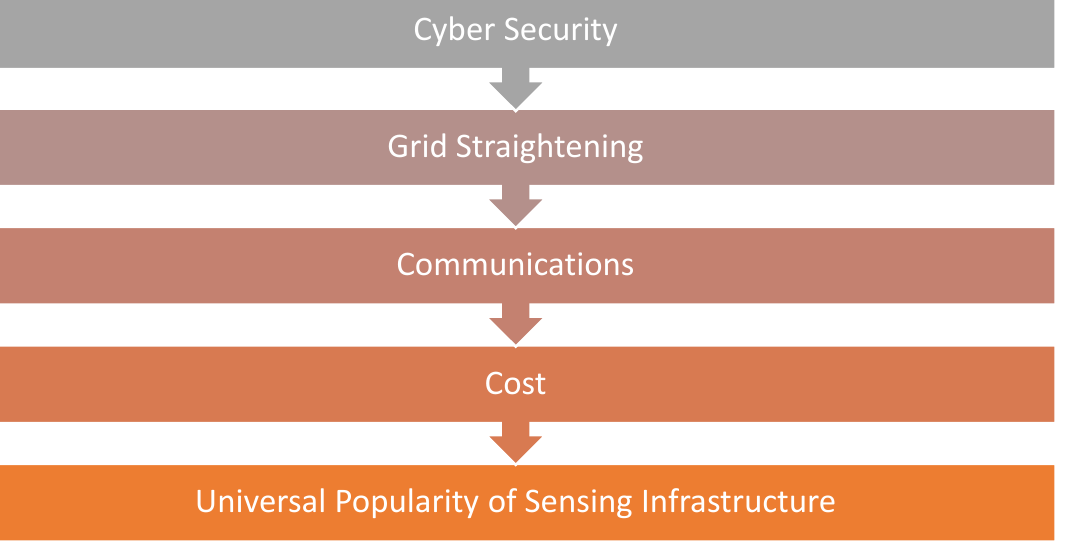
Figure 10. Challenges overview.